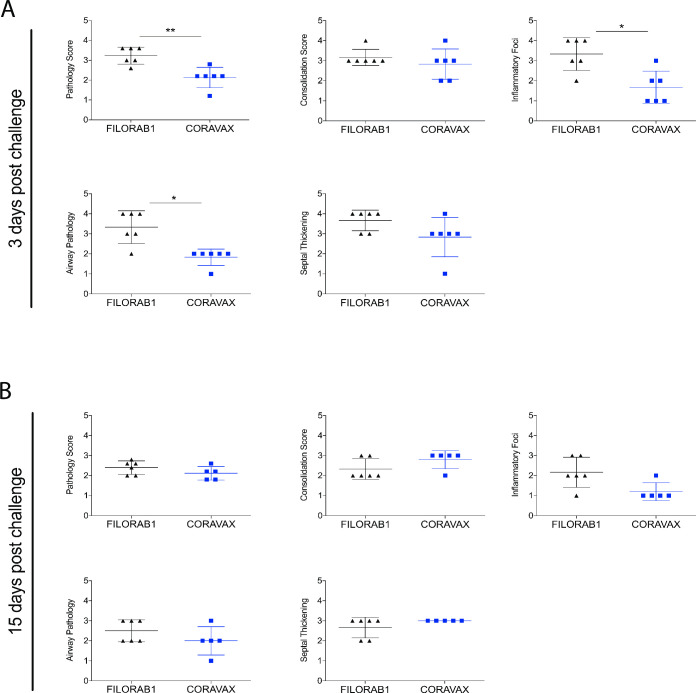
Comparative pathology scores for lungs from CORAVAX vaccinated and control hamsters post SARS-CoV-2 challenge.Scores at 3 days (A) and 15 days (B) p.c. Scores are displayed for overall lung pathology and individual criteria, including consolidation or extent of inflammation, type inflammatory foci, airway pathology, and septal thickening. The pathology scores (mean) were calculated based on the criteria described in S1 Table. The CORAVAX vaccine group is shown in blue and the control group in black. Data represent mean ± S.D., N = 6 for FILORAB1 group day 3 and day 15 time points and N = 6 for CORAVAX vaccine group at day 3 and N = 5 for CORAVAX day 15 time points. P > 0.123 (ns), P < 0.033 (*), P < 0.002 (**), P < 0.001 (***). Only significant differences are depicted.